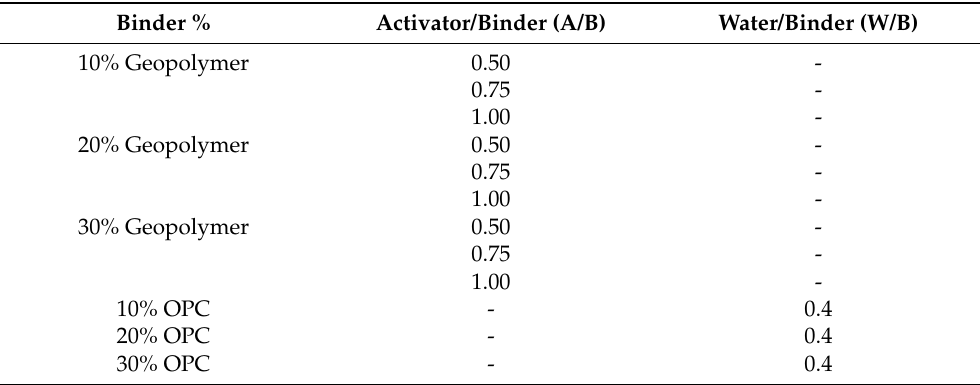
Table 3. Geopolymer and OPC–clay